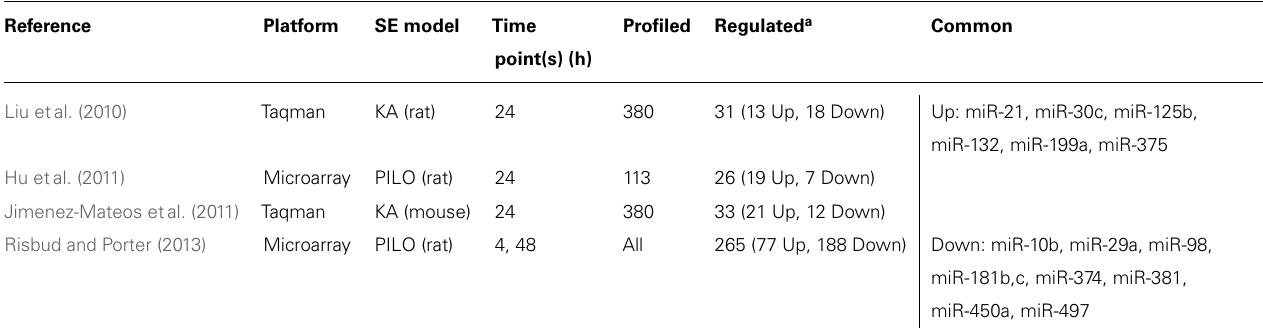
Table 1 | miRNA profiling after status epilepticus.